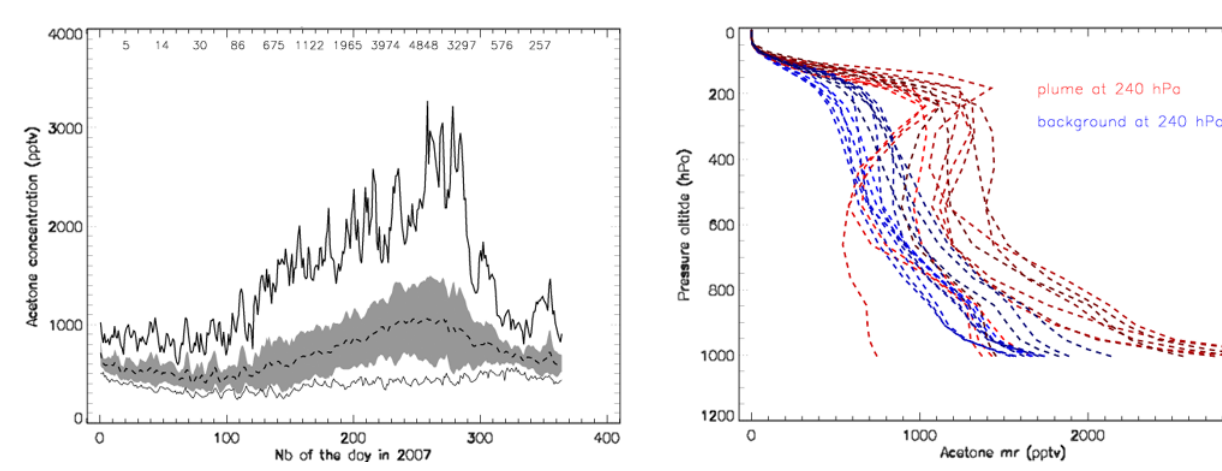
Fig. 7. Vertical profile of monthly average of acetone vmr simulated by LMDz-INCA over South Asia extended region, in background conditions and during 238-hPa ppbv-event (238-hPa acetone vmr >